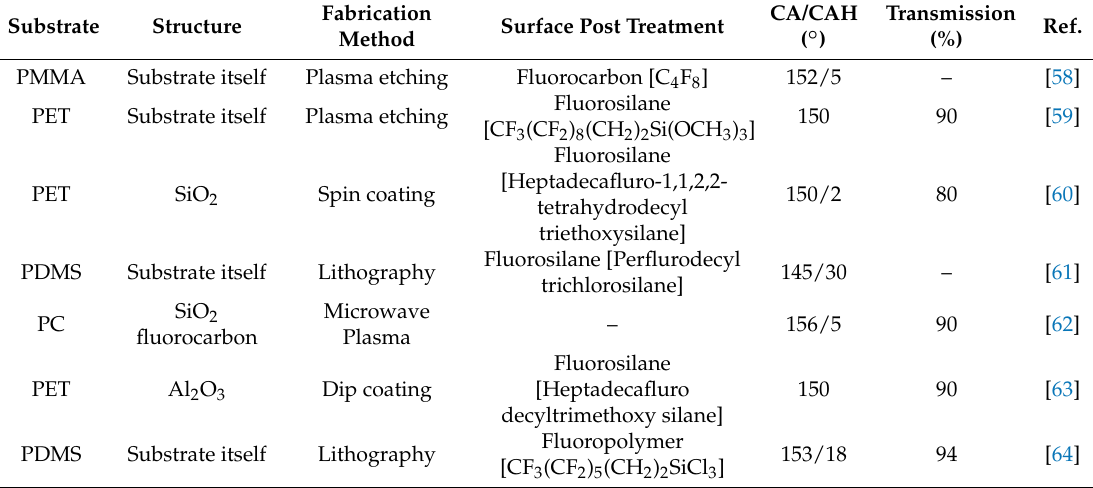
Table 1. Summary of various materials and methods reported for fabrication of transparent superhydrophobic